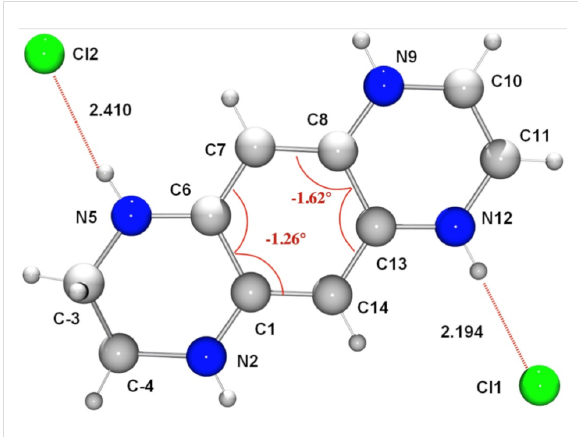
Figure 3: The ORTEP view of 6a . Torsion angles within the benzene ring are given in red.